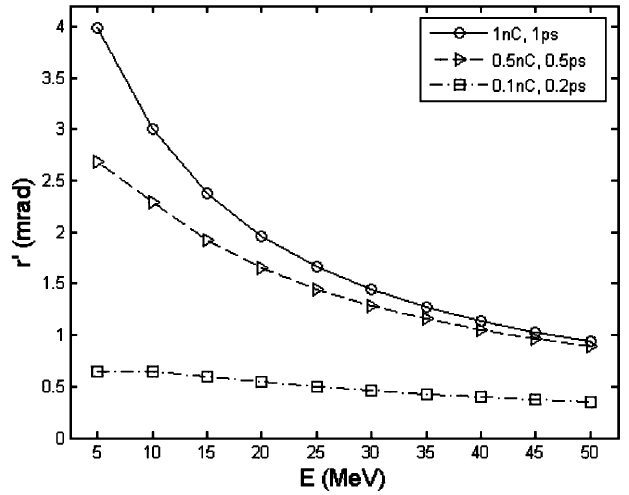
FIG. 4. The dependence of deflection on beam energy with other things being equal.